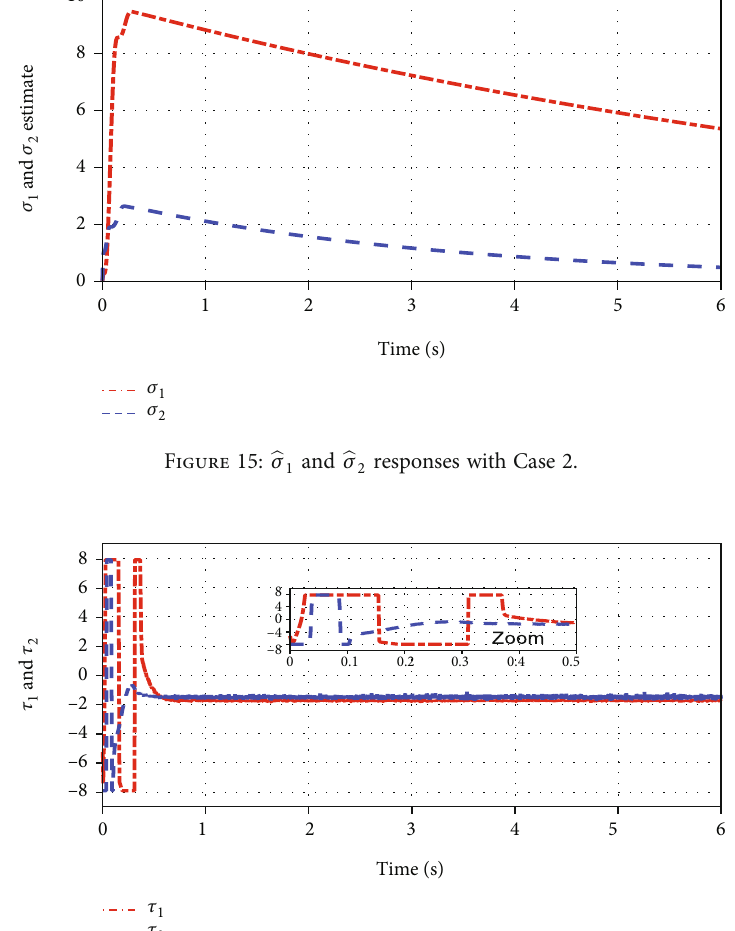
Figure 16: Control input of the proposed method with Case